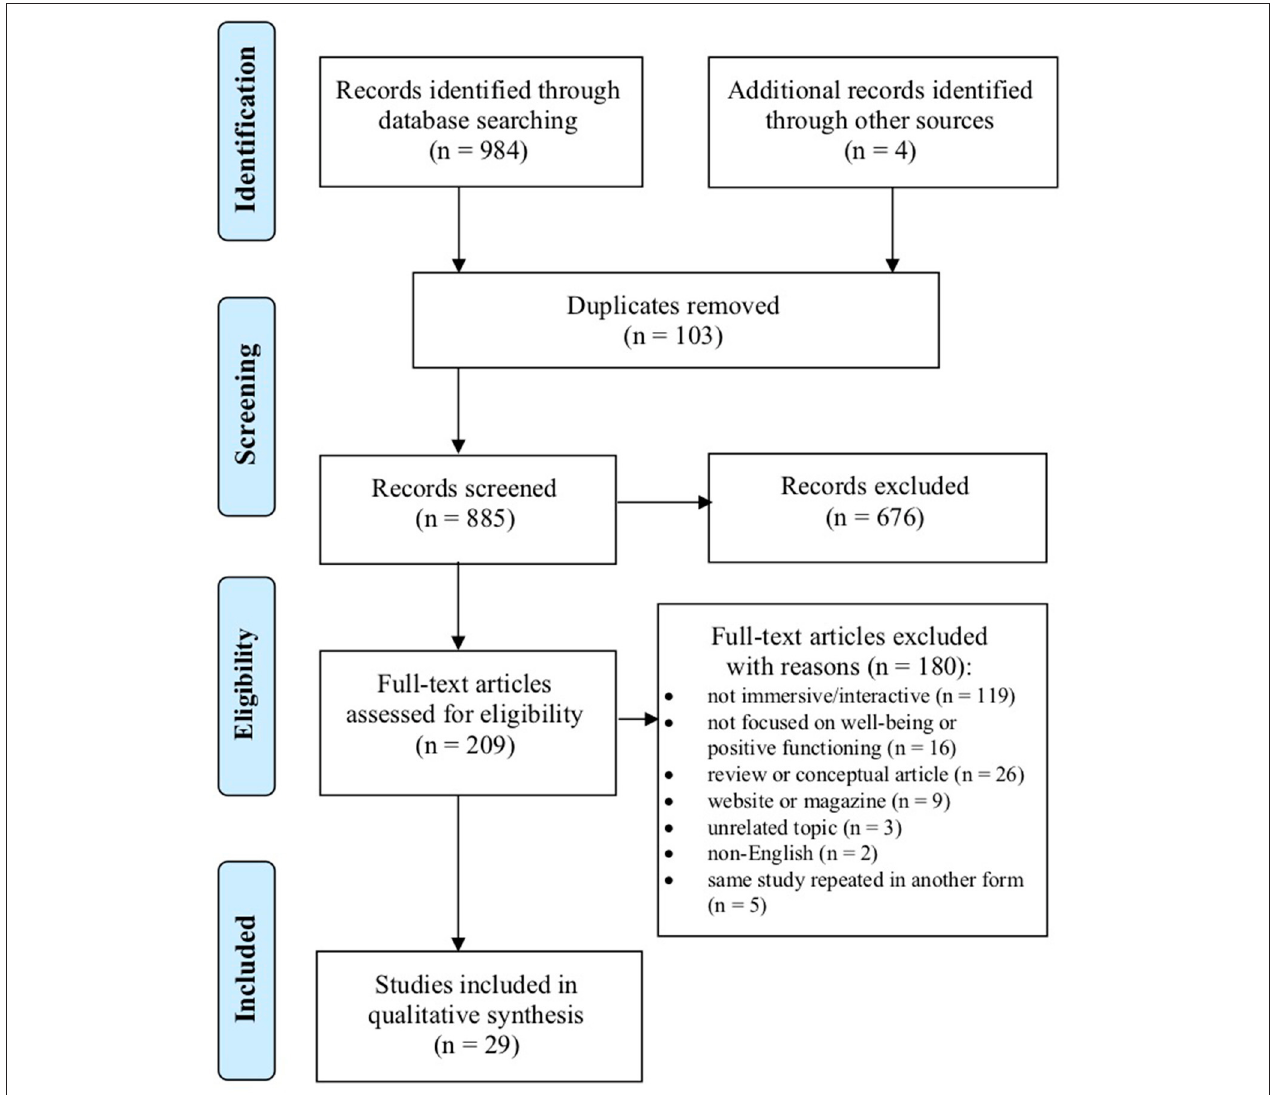
FIGURE 2 | Flowchart of the included and excluded articles from the assessment of screening and eligibility